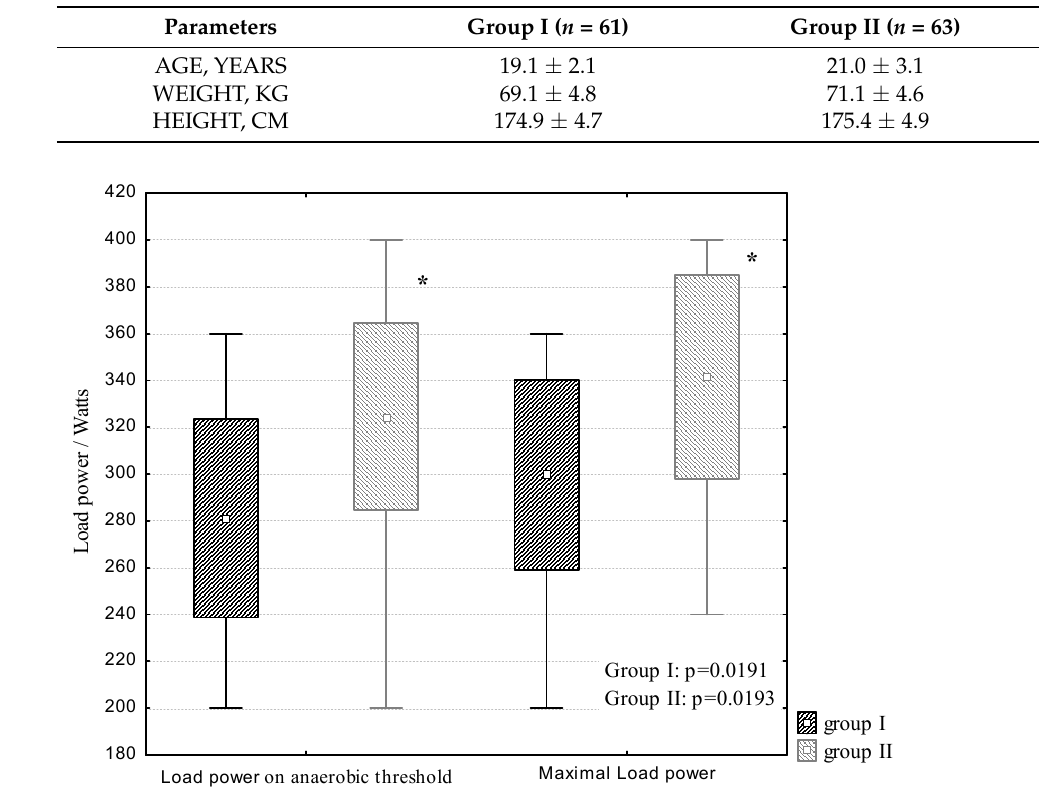
Table 1. Characteristics of the subjects by group, ME ± SD.